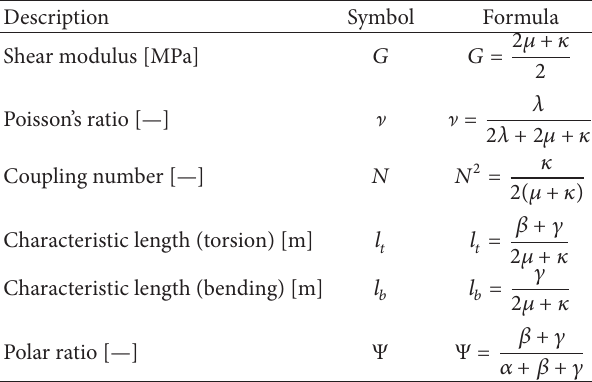
Table 1: Micropolar material